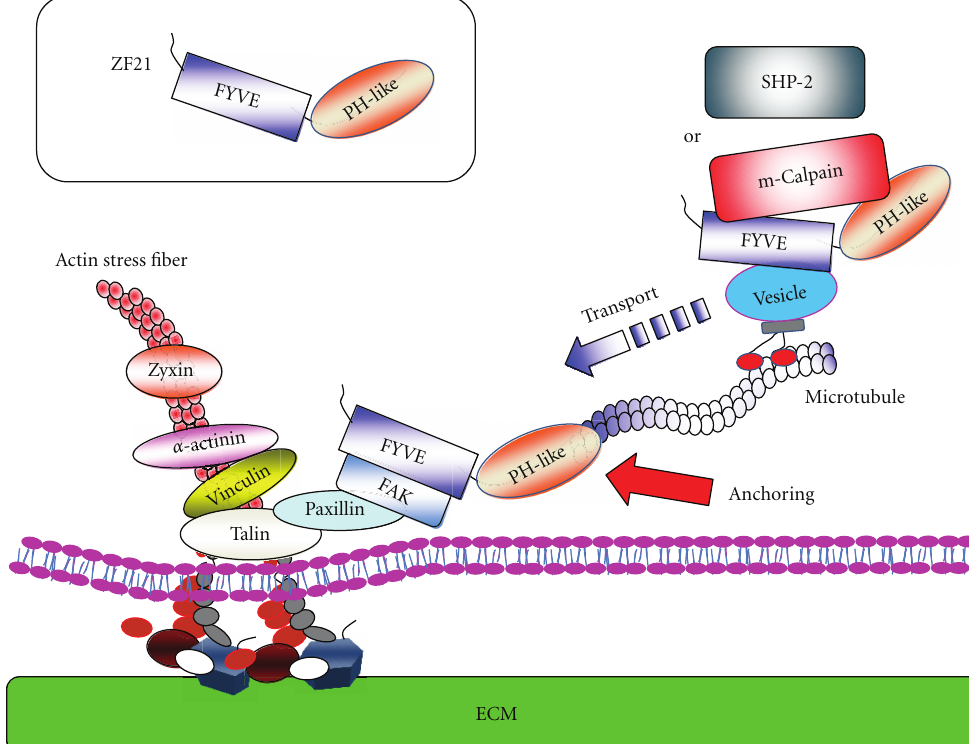
Figure 5: A model for the recruitment of disassembly factors to FAs. In this model, ZF21 conveys FA disassembly factors via intracellular vesicle transport on MTs. ZF21 associates with endosomal vesicles by binding to phosphatidylinositol-(3)-phosphate via its FYVE domain. m-Calpain and SHP-2 can be loaded onto ZF21 carried by the vesicles. ZF21 also can be found in FAs by interacting with FAK, and the ability of ZF21 to bind β -tubulin may act as a docking function for the extended MTs into FAs in order to unload the conveyed factors at the destina-